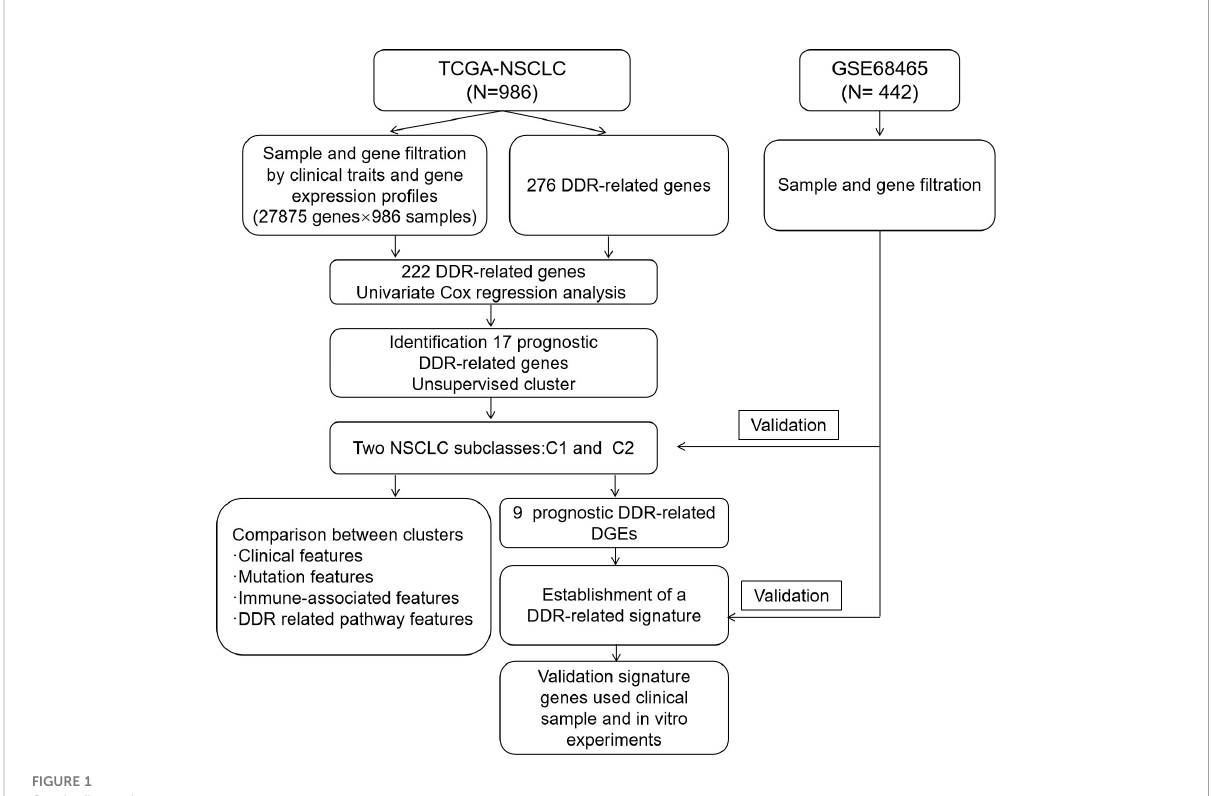
FIGURE 1 Study fl ow